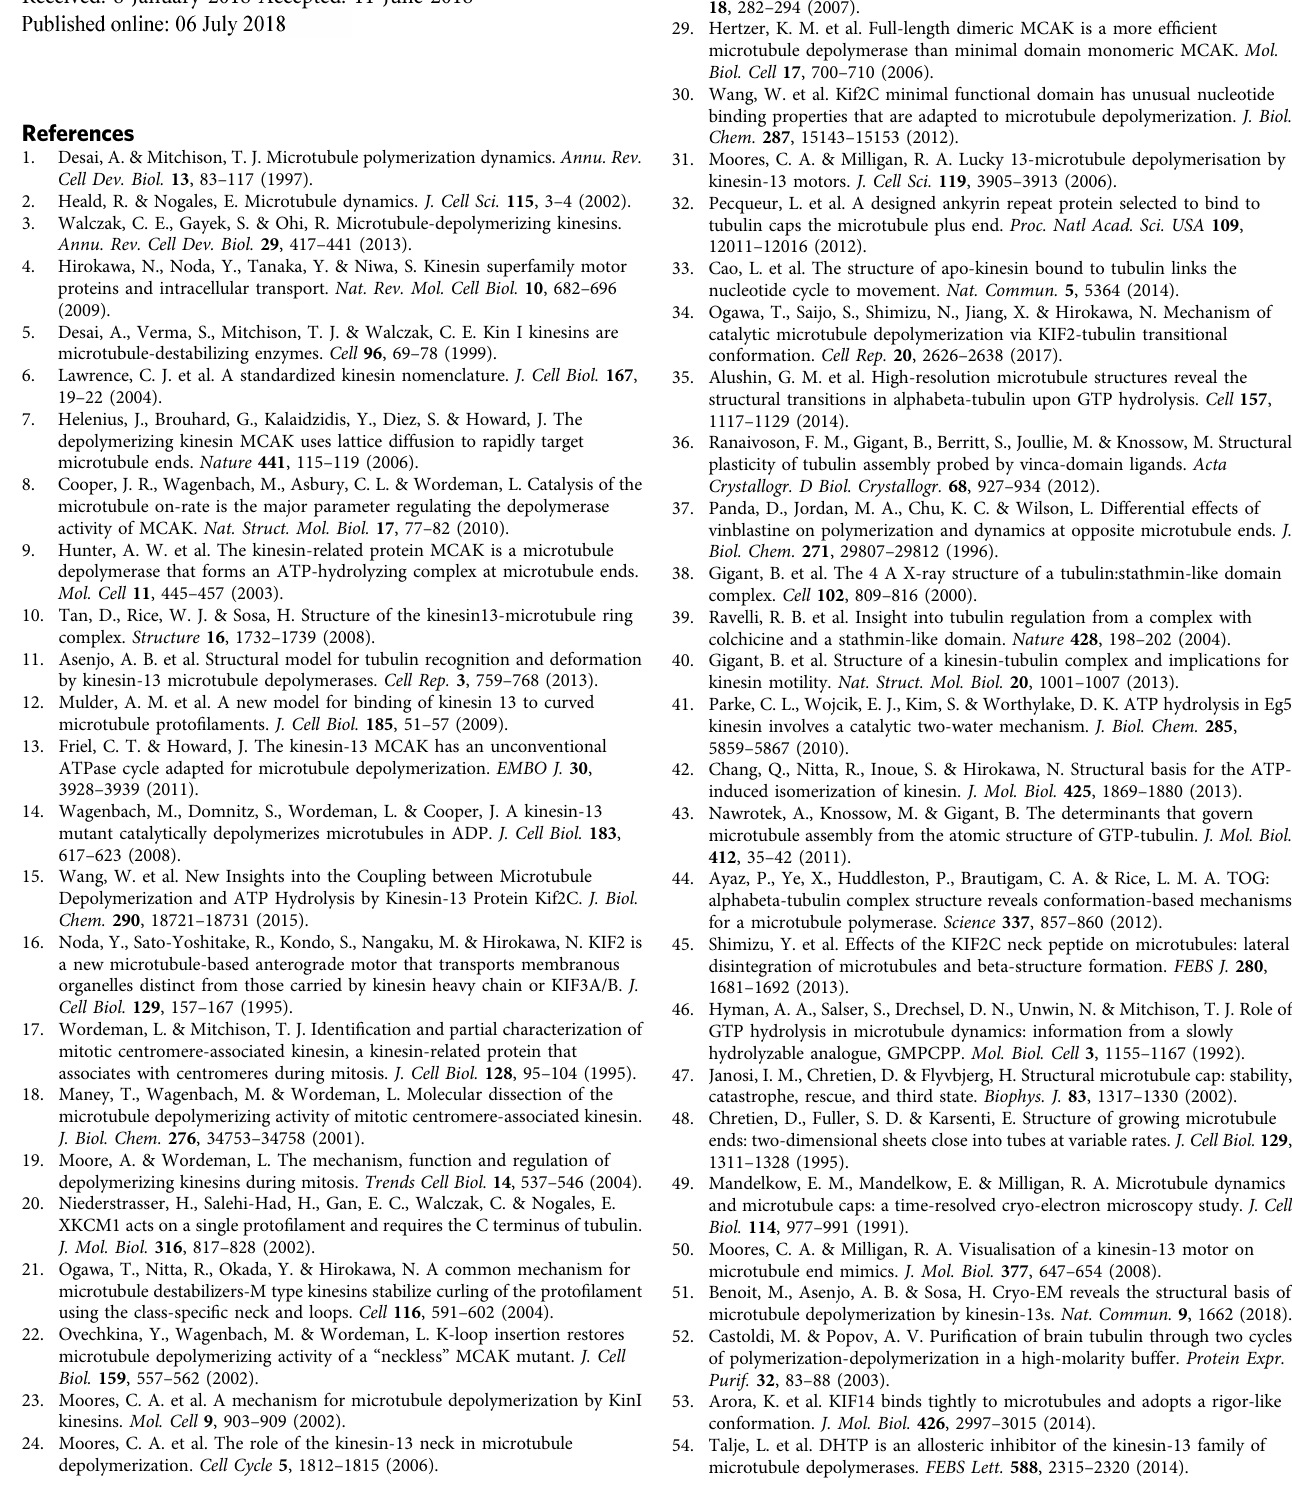
(theoretical) scattering curve of the Kif2A-NM – tubulin – DARPin complex crystal structure using the program CRYSOL 66 . Data availability . Coordinates and structure factors have been deposited in the Protein Data Bank with accession code: 6BBN. SAXC data and models have been deposited in the Small-Angle Scattering Biological Data Bank with accession code: SASDCR9. Other data are available from the corresponding authors upon rea- sonable